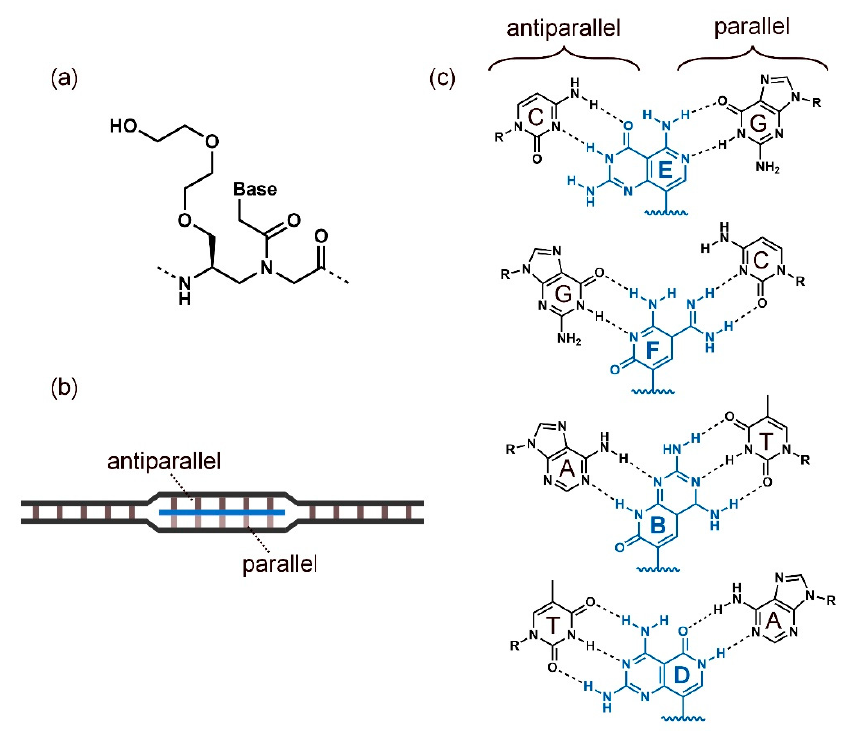
Figure 12. ( a ) Structure of γ -miniPEG PNA. ( b ) Bifacial PNA (JB γ PNA) recognizes two strands of dsDNA simultaneously in both antiparallel and parallel orientations. ( c ) Bifacial nucleobases form hydrogen bonds with canonical nucleobases on the two sides of bifacial nucleobases.